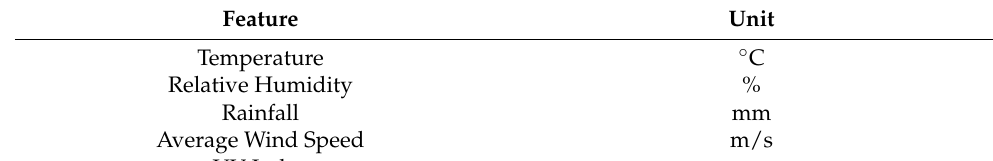
Table 4. Final features selected from the CWB.